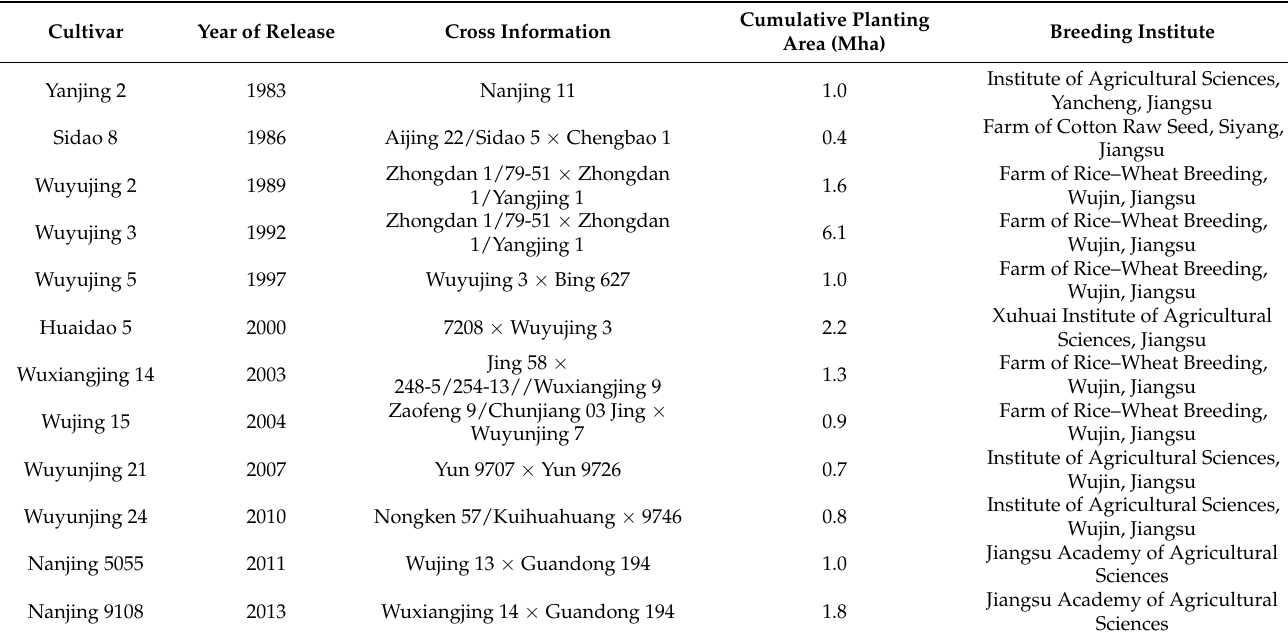
Table 1. The information on year of release, cross information, cumulative planting area, and breeding institute of rice